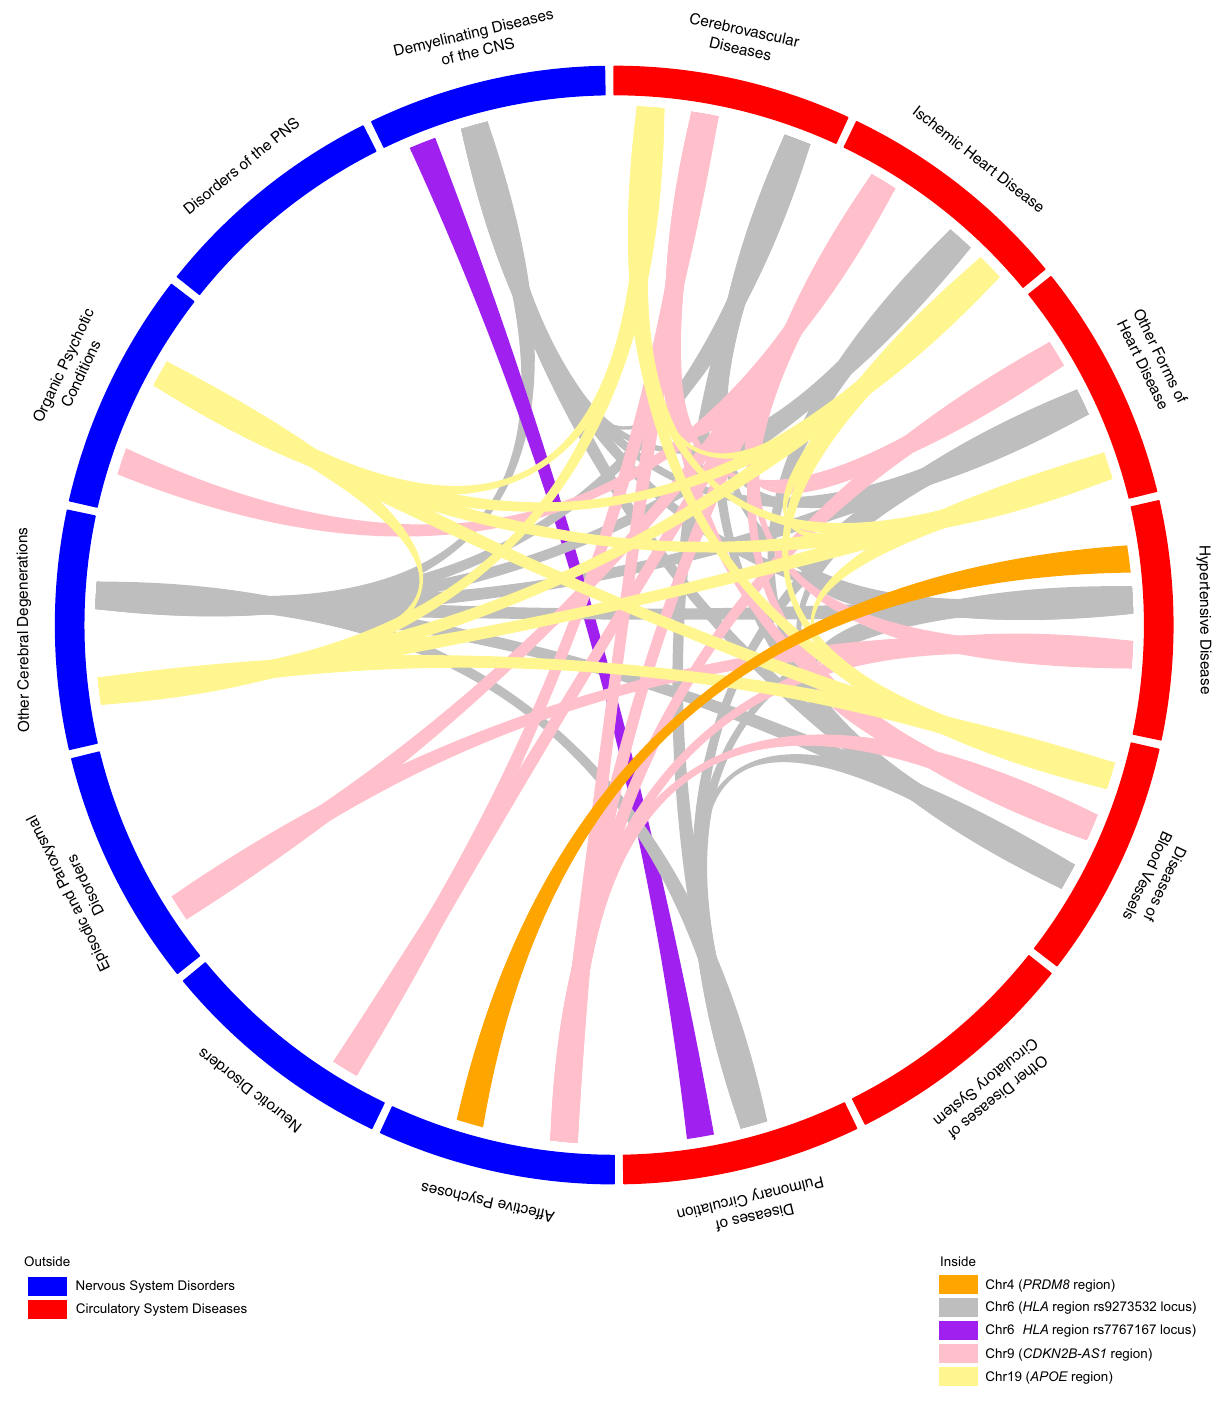
Fig. 5 Disease relationships linked by pleiotropic SNPs. The results are obtained from sequential multivariate analyses for both eMERGE network and UK Biobank. We demonstrate pleiotropy among disease categories by connecting them using SNPs that are signi fi cantly associated with at least one nervous system and one circulatory system disease